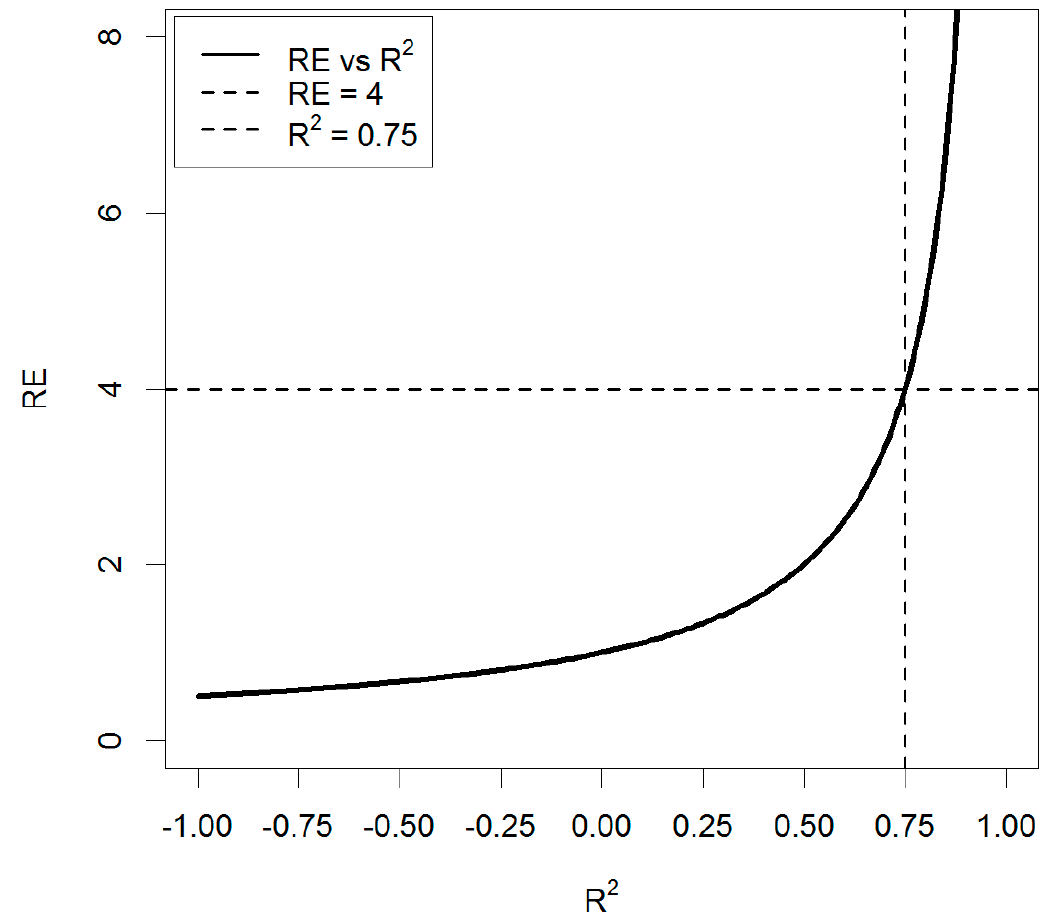
Figure 5. Deterministic relationship between Relative Efficiency (RE) and R 2 .